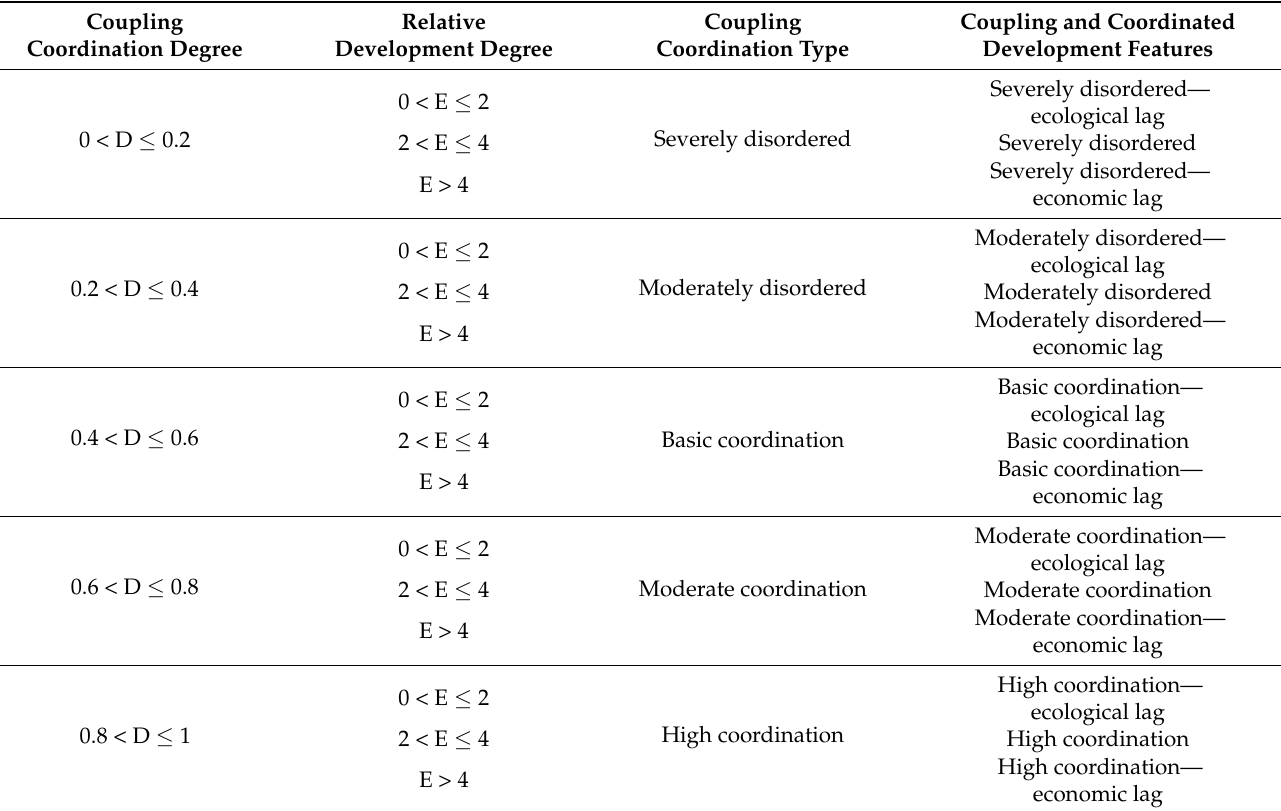
Table 2. Types and division criteria of coupling and coordinated development between GEP and economic